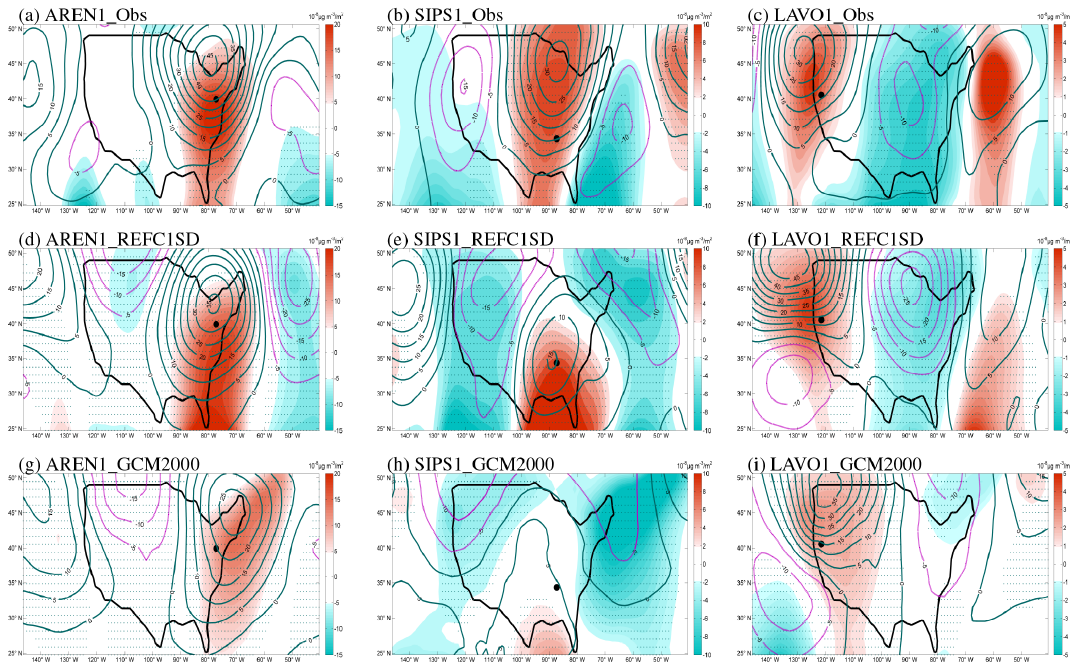
Figure 4. Composite 500hPa geopotential height anomaly (contours; positive values are represented by green lines and negative values by magenta lines) and regression coefficients (shaded) between daily AWA and PM 2 . 5 at sites (denoted by the black dots) (a, d, g) AREN1, (b, e, h) SIPS1 and (c, f, i) LAVO1 in the study domain for daily JJA time series of current climates. The top row shows results using IMPROVE PM 2 . 5 and reanalysis AWA, the middle row uses the reanalysis-driven simulated PM 2 . 5 (REFC1SD) and reanalysis AWA, and the bottom row uses current-climate-simulated PM 2 . 5 and AWA (GCM2000). Stippling indicates the regions that are statistically significant at the 5% confidence level. Unit: 10 − 8 µgm − 3 m 2 for regression